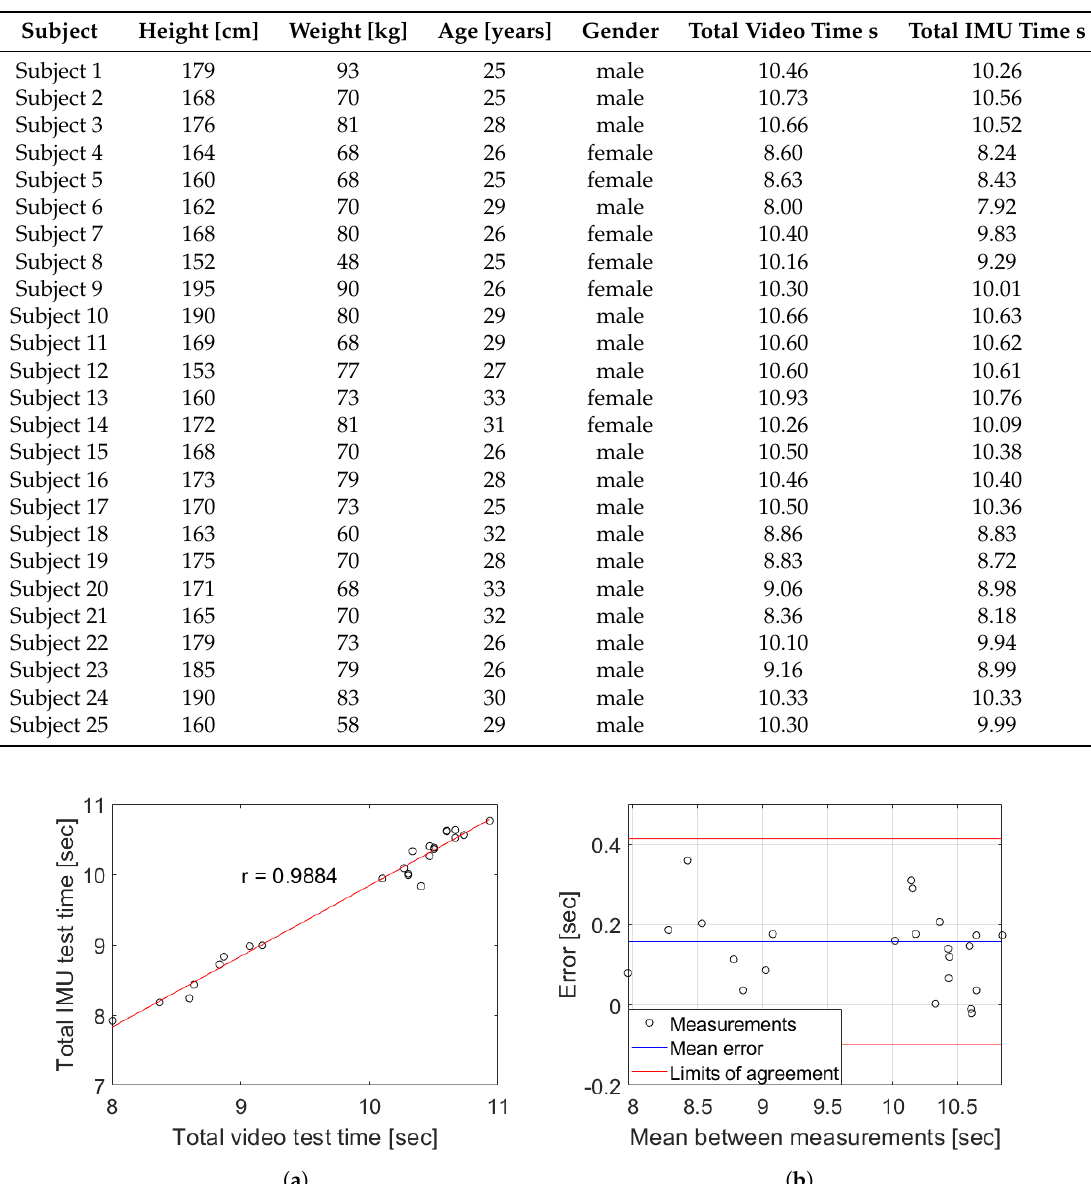
Table 2. Results from the measurements obtained by the proposed methodology versus the typical visual clinical procedure in young subjects.